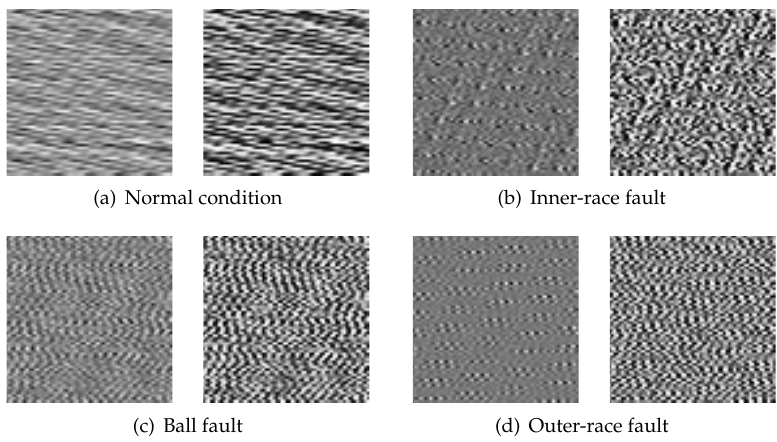
Figure 2. Four gray images with different conditions of rolling-element